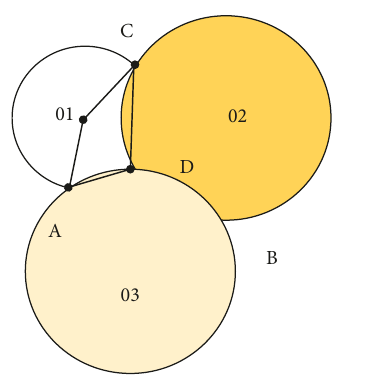
Figure 4: Schematic diagram of triangular positioning method.